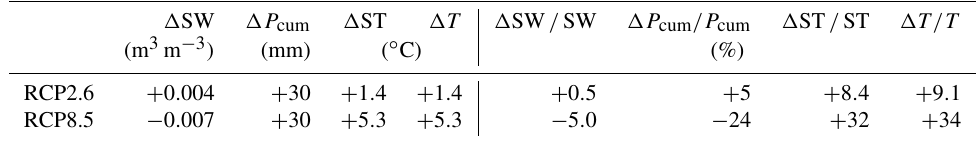
Figure 6. Seasonal variations of the relative contribution of the different frequencies as considered in G 14 (0, 7, 14, and 21 days before the measurement) among the regressor x i selected in G 14, under (a) ND ( n = 267) and (b) AD ( n = 138). The frequency “0”, “ − 7”, “ − 14”, “ − 21” includes the contribution of “ L -1, T -1, SW-1, T 0, L 0, T M - T m ”; “SW-7, ST-7, P -7”; “ T -14, SW-14, ST-14, P -14”; and “ T -21, SW-21, P -21” respectively. Table 2. Annual absolute and relative changes to the present of SW, P , ST and T according to the RCP2.6 and RCP8.5 scenarios. Present and future cases were calculated for 2000–2010 and 2090–2100